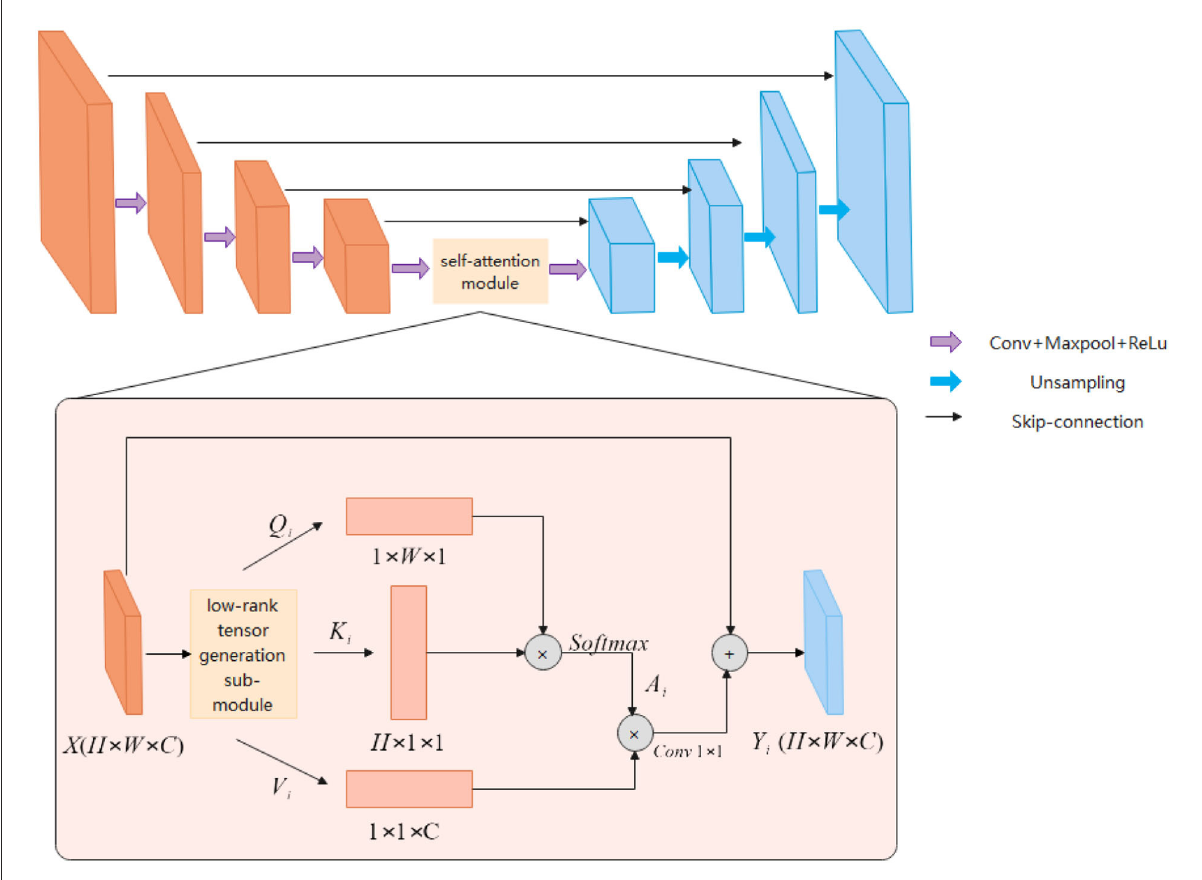
FIGURE1 ESA-UNet network structure